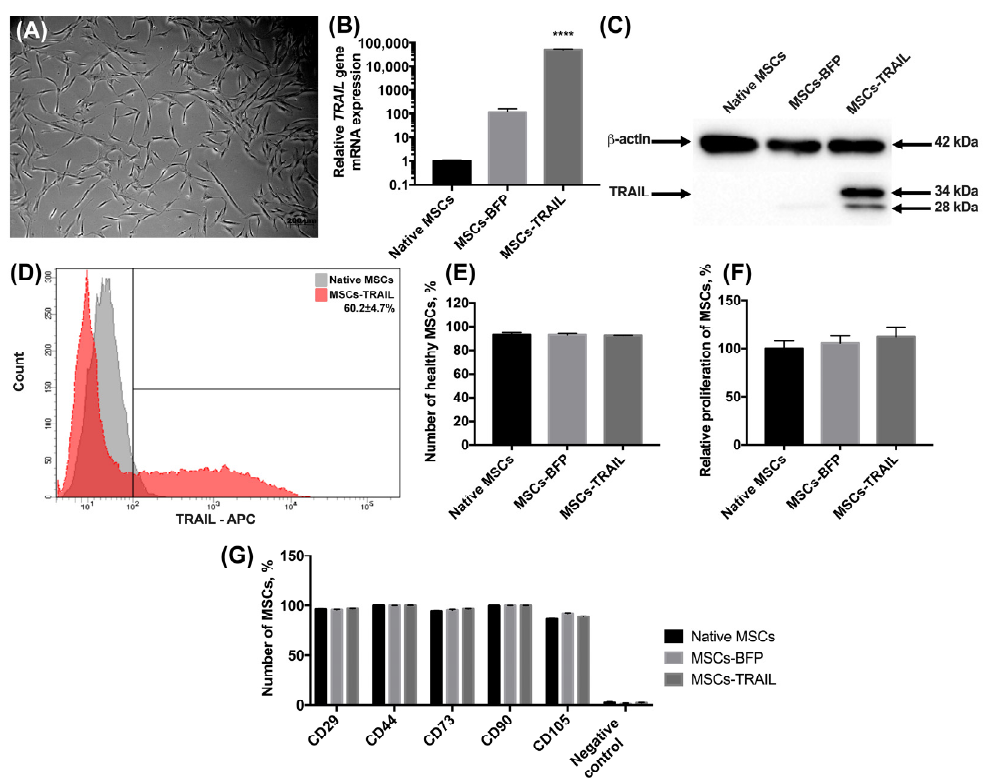
Figure 1. Characterization of MSCs after genetic modification. ( A ) Newly isolated MSCs. Phase- contrast light microscopy, scale bar: 200 µm. ( B ) Genetically modified MSCs-TRAIL and MSCs-BFP expressed by 52,591 times and 100 times more copies of TRAIL gene, respectively, compared to native MSCs. 18S RNA reference gene has been used for normalization of the data. Bars represent the mean of three replicates with their corresponding standard deviation ( n = 3). ( C ) Expression of two isoforms of TRAIL protein in MSCs-TRAIL (28 and 34 kDa) was confirmed using Western blot. ( D ) About 60 % of MSCs-TRAIL carried the TRAIL on their surface. ( E ) Number of alive MSCs was the same in all the groups after 48 h of cultivation. Bars represent the mean ± SD ( n = 3). ( F ) TRAIL overexpression also failed to affect relative proliferation rate of MSCs. Each value is presented as the % in relation to the control (native MSCs) group. Bars represent the mean ± SD ( n = 3). ( G ) The immunophenotype of native and genetically modified MSCs also remained unchanged after genetic modification. Data were received by flow cytometry and are shown as the mean percentage ± SD ( n = 3). **** p < 0.0001.